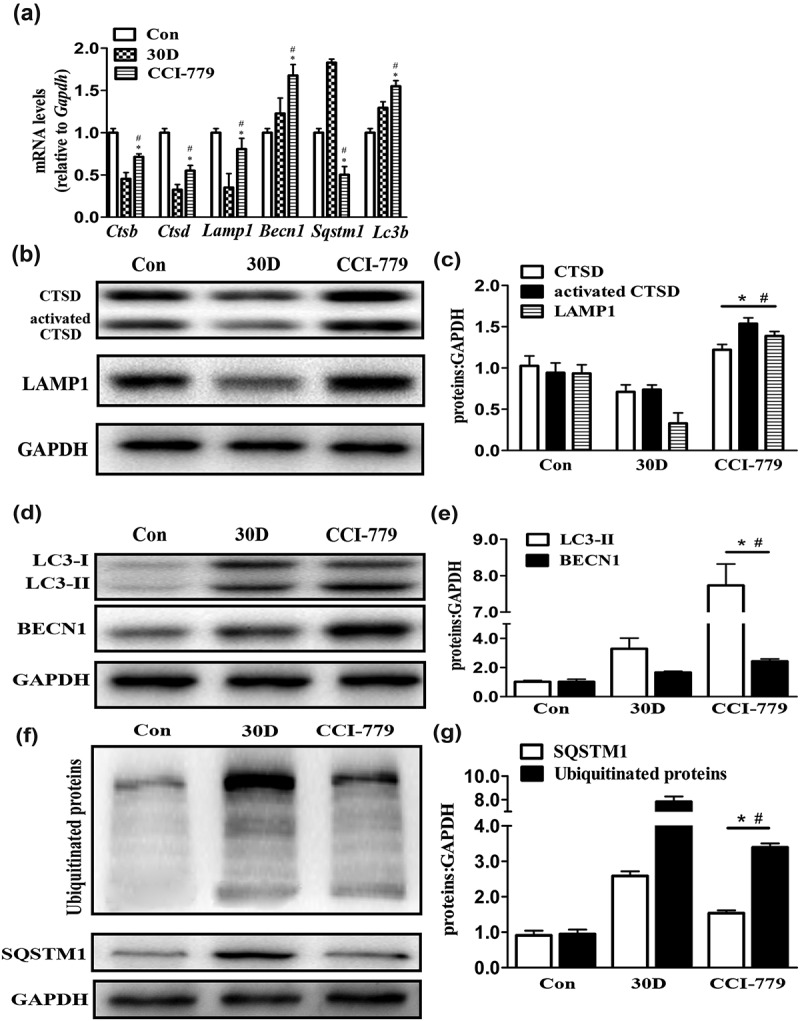
CCI-779 significantly rescued the impaired autophagy-lysosomal pathway in degenerated SGNs of mice. (a) The levels of Ctsb, Ctsd, and Lamp1 and of the autophagic genes Becn1 and Lc3b were significantly higher, and Sqstm1 was lower in the experimental group than in the negative control group, which was determined by quantitative real-time PCR. (b and c) The LAMP1 and CTSD levels determined by western blotting were consistent with the quantitative real-time PCR results. (d and e) Compared with those in the negative control group, the LC3 and BECN1 levels in the experimental groups were significantly increased, as determined by western blot assays. (f and g) The western blot results revealed that the levels of the autophagic cargo receptor SQSTM1 and ubiquitinated proteins were decreased significantly in the experimental group compared with those in the negative control groups. *, the difference between the experimental group and the blank control group was significant (P < 0.05); #, the difference between the experimental group and the negative control group was significant (P < 0.05); CCI-779, experimental group; 30D, negative control group; Con, blank control group.